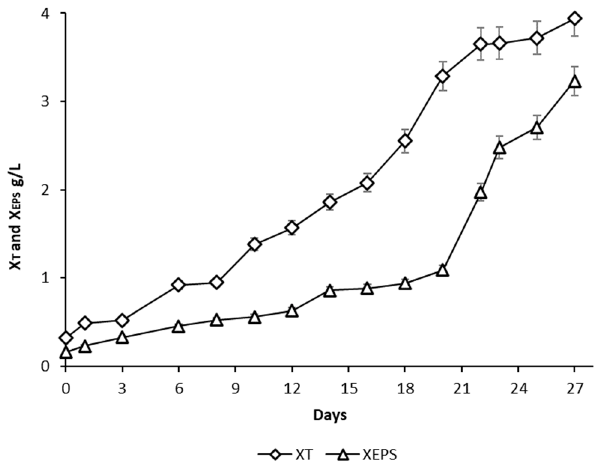
Figure 6. Total biomass dry weight (X T ) and the extracellular polysaccharides dry weight (X EPS ) pro- duced during cultivation of Dictyosphaerium chlorelloides in a 60 L airlift photobioreactor in a 6-fold diluted full medium. Error bars indicate the standard deviations. The experiment was carried out in one biological replicate.